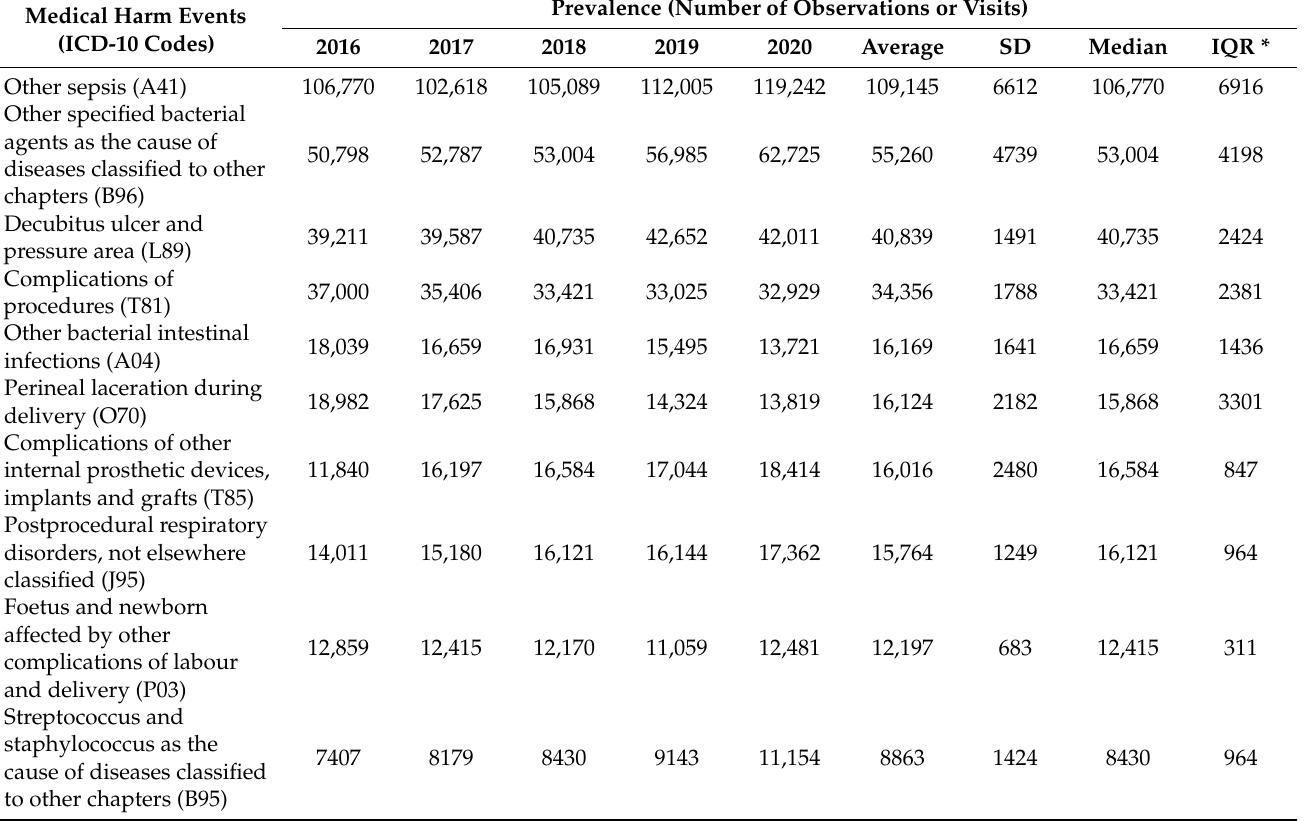
Table 5. Top 10 medical harm events in inpatient departments, ranked by average prevalence, between 2016 and